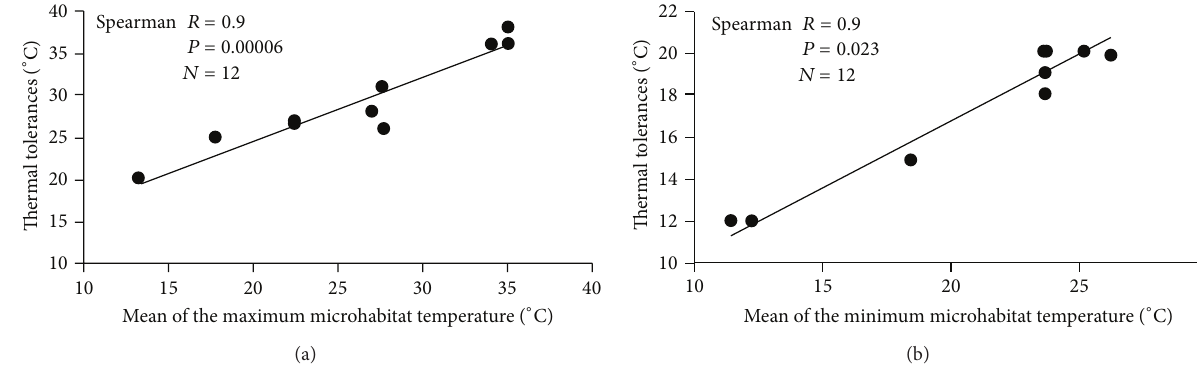
Figure 2: Relationship between the mean of the embryonic microhabitat temperatures and the maximum (a) and minimum (b) embryonic thermal